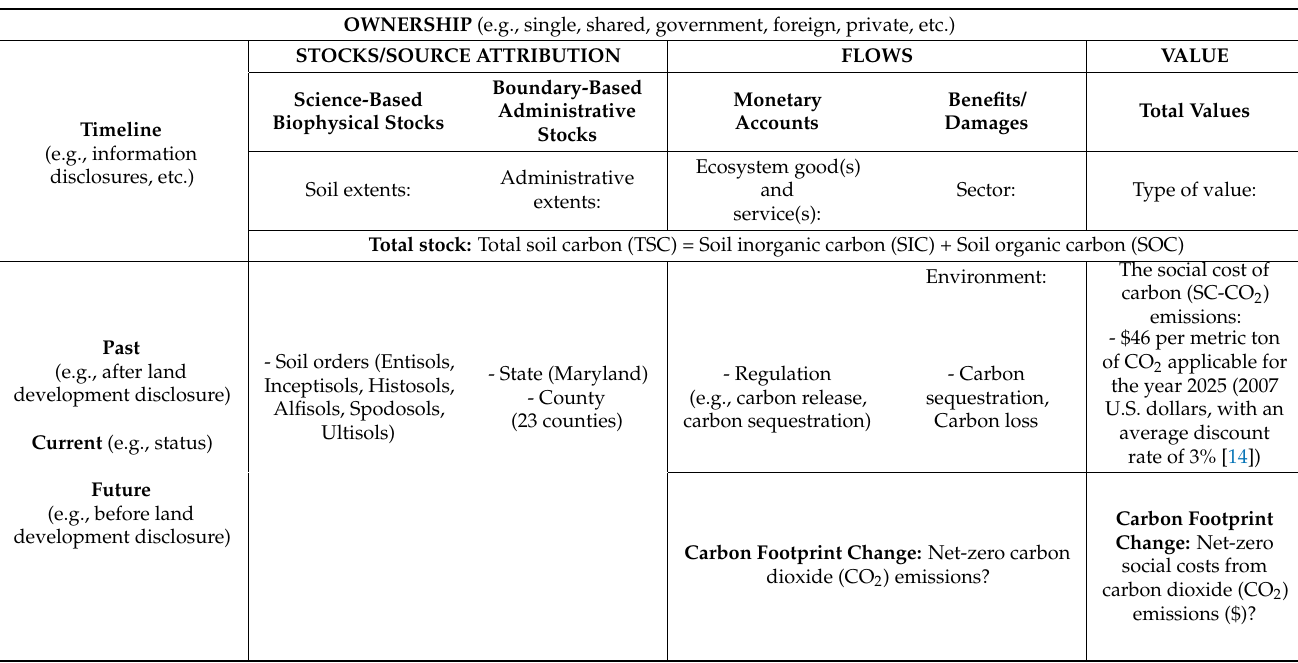
Table 2. A description of the accounting framework (modified from Groshans et al. (2019) [16]) adapted for net-zero (e.g., net-zero carbon dioxide (CO 2 ) emissions) target accounting. OWNERSHIP (e.g., single, shared, government, foreign, private,